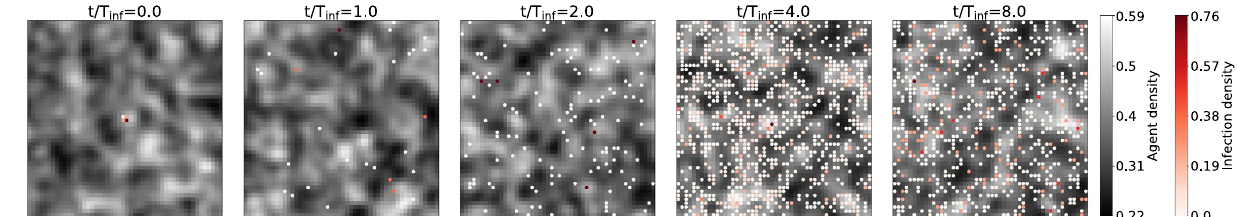
Figure 4. Infection dynamics in a disordered homogeneous state. The greyscale lattice displays the smoothed local mean density of all agents within each square bin. Overlaid dots, colored from white to red, show the density of agents in state I (i.e., of infectious agents) only on bins where I > 0 . The spatial dynamics corresponds to the disordered homogeneous state D presented in Fig. 1, with (Pe,g) = (32,1). The panels display the temporal 3 evolution of a single infection process (with T inf = 10 and (cid:31) = 2 ) started by 10 agents at the center of the arena. We observe that the initial localized outbreak can quickly infect agents anywhere in the